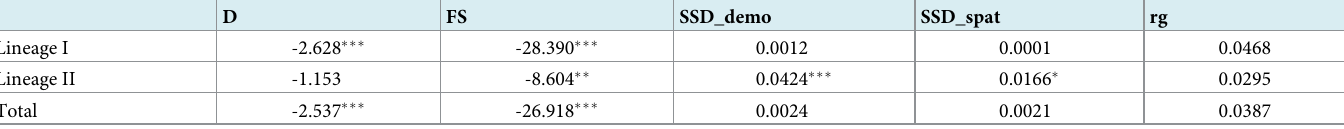
Table 2. Results of demographic analyses on COI sequences in the two lineages of Lucanus cervus .